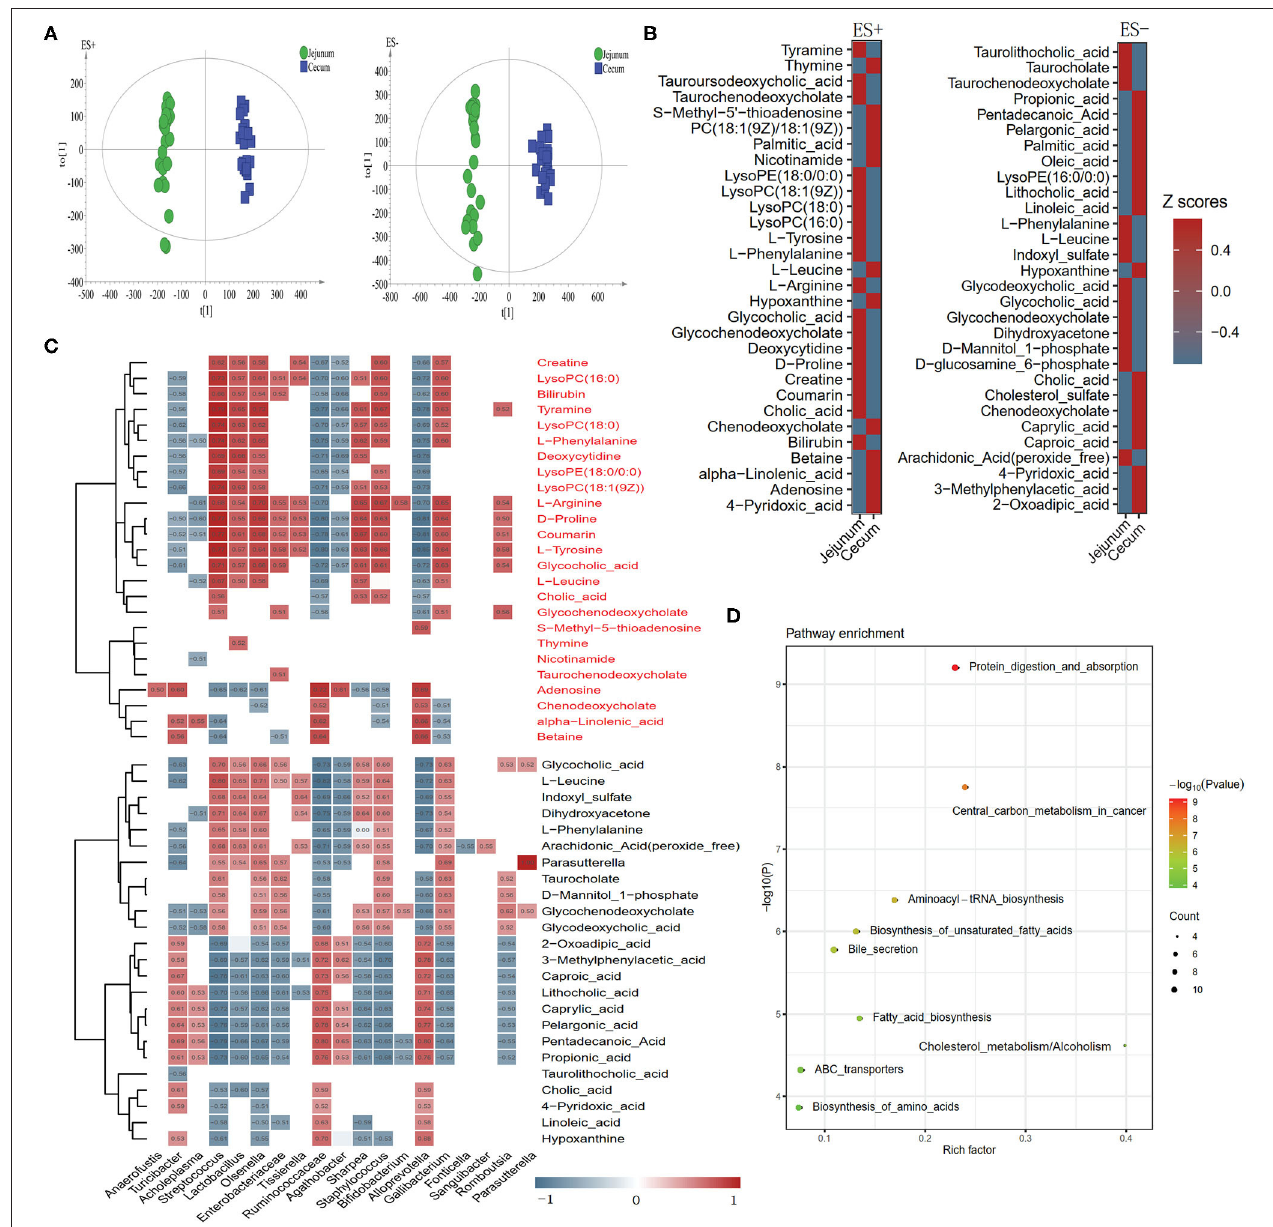
FIGURE 6 | Different metabolic patterns in the cecum and jejunum. (A) Score scatter plots of OPLS-DA based on the metabolic profiles in content samples from the cecum and jejunum of pigs in ES + and ES–. (B) The top 30 metabolites in ES + and ES– that were significantly changed in the cecum compared to the jejunum at VIP > 1 and p value (t test) < 0.05 are identified. (C) The relationship between 60 endogenous metabolites and the top 30 altered genera ( Figure 2D ) in the cecum and jejunum is estimated by Spearman’s correlation analysis. Those with low correlation (| r | < 0.5) are not shown. (D) The top 10 pathway enrichment analyses performed using the significantly different metabolites between the cecum and jejunum. ( Figure 7A ). The compositional changes in individuals from the treatment involved 167 analytes that were significantly different between the treatment groups and the control and 58, 33, and 76 analytes were altered in group I, group II, and group III, respectively ( Figure 7B ). There were 10 metabolites that were obviously different in all three treatment groups compared to the control group ( Figure 7C ).